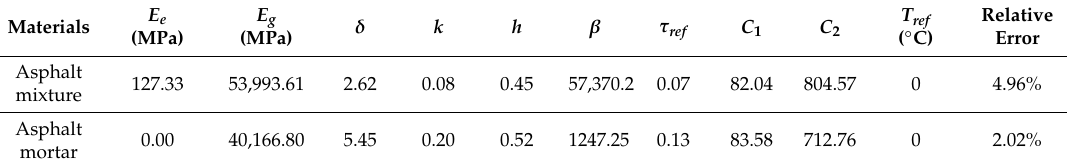
Figure 4. Test data and fitting curve of the asphalt mortar for the dynamic modulus and phase angle. As mentioned above, to convert the continuous spectrum into the discrete spectrum efficiently, the relation times are uniformly distributed on the logarithmic time axis, so Equation (17) can be rewritten as: